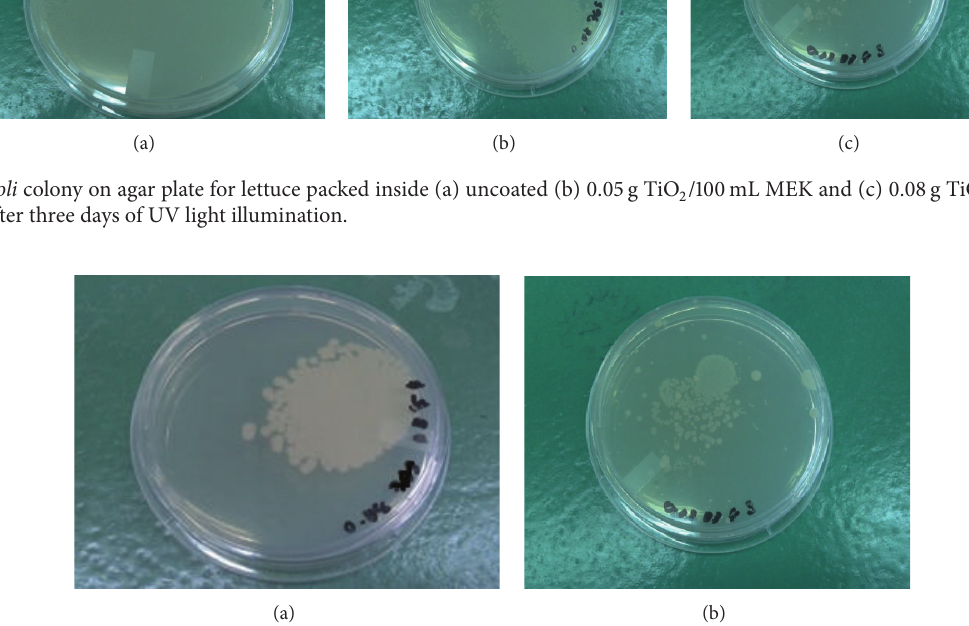
Figure 3: E. coli colony on agar plate for lettuce packed inside 0.08 g TiO 2 /100mL MEK films after three days of (a) fluorescent and (b) UV light